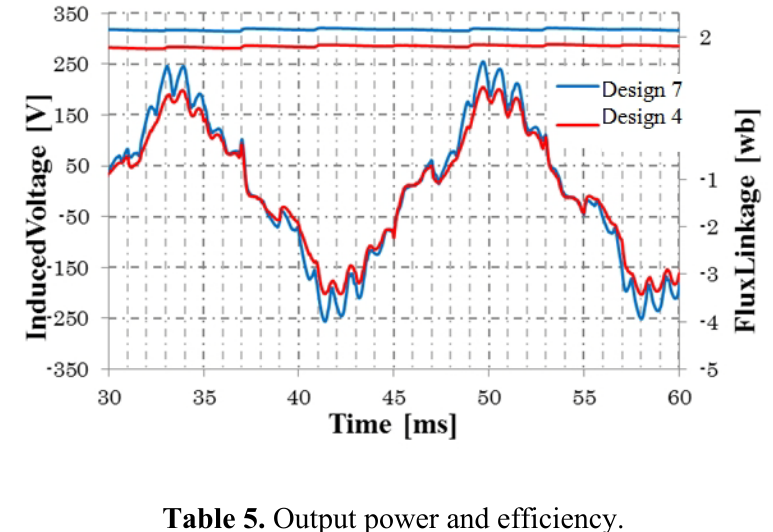
Figure 20. Flux linkage and induced voltage of Design 1 and Design 4.